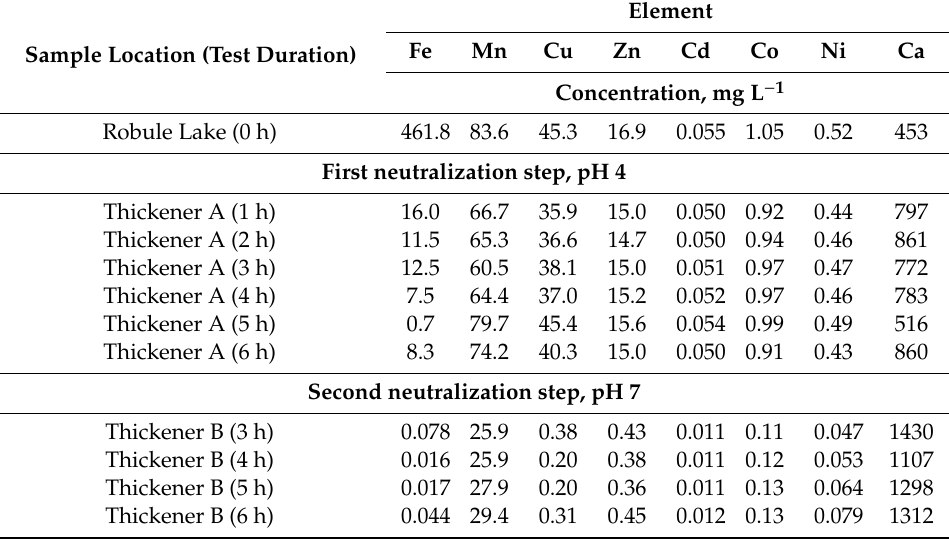
Table 5. Concentration of elements in AMD neutralized in the two-step neutralization treatment on the semi industrial